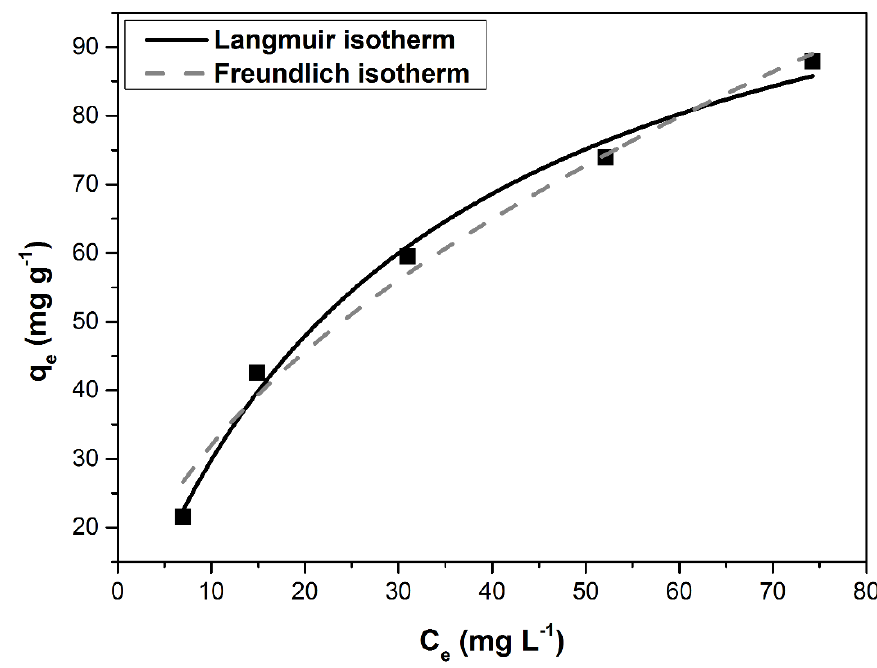
Figure 6. Langmuir and Freundlich isotherms for MB adsorption on DBPH powder. Table 4. Langmuir and Freundlich adsorption isotherms constants.